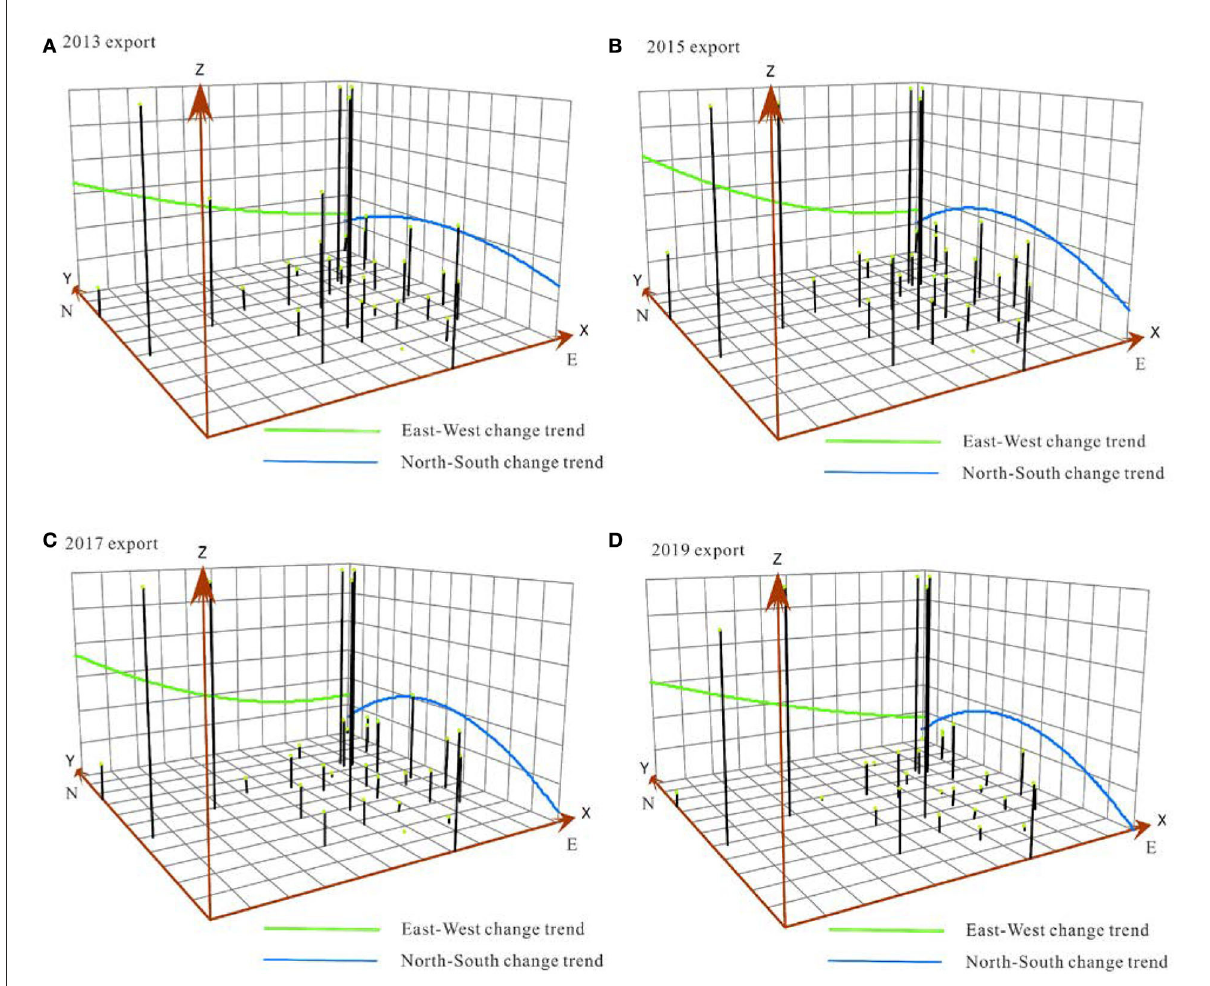
FIGURE6 Spatial change trend of the HHI of railway container freight at the provincial scale